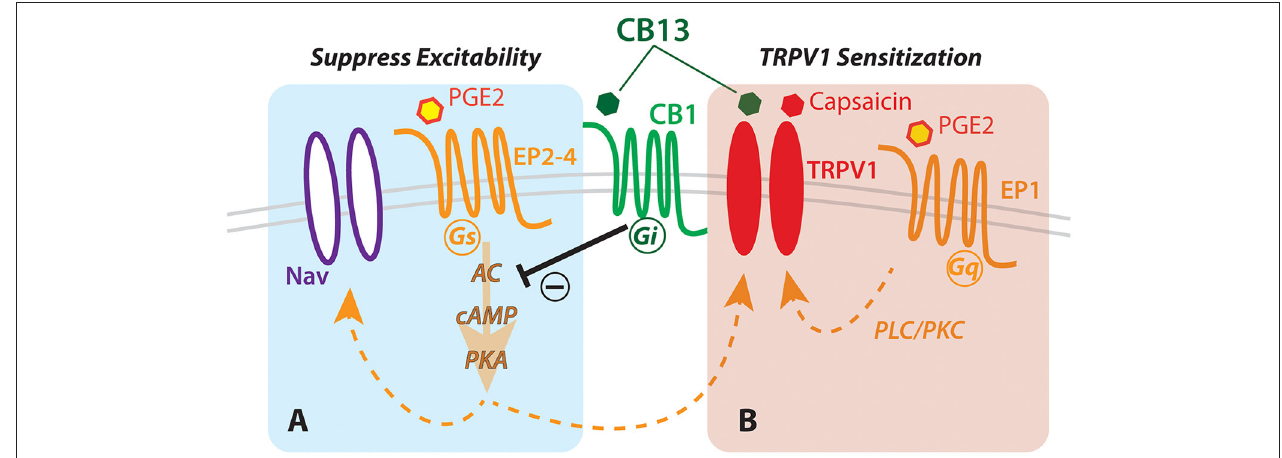
FIGURE 4 | Hypothesized schematic of cannabinoid interaction with TRPV1 and EP receptors in human sensory neurons. Dual actions of cannabinoid (CB13) on the CB1 receptor leading to (A) G-protein-coupled receptor-mediated inhibition of cAMP production via prostaglandin receptor, and (B) direct action on TRPV1 leading